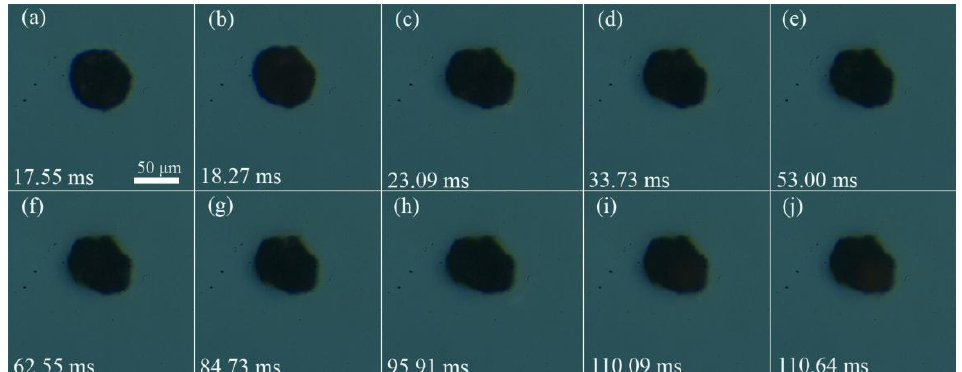
Figure 8. Representative snapshots of melting stage of individual Mg microparticle. (Images acquired from Supplementary Materials, Video S1, recording frame: 11,000 fps; exposure time: 99 μs). ( a ) 17.55, ( b ) 18.27 ms, ( c ) 23.09 ms, ( d ) 33.73 ms, ( e ) 53.00 ms, ( f ) 62.55 ms, ( g ) 84.73 ms, ( h ) 95.91 ms, ( i ) 110.09 ms, ( j ) 110.64 ms.